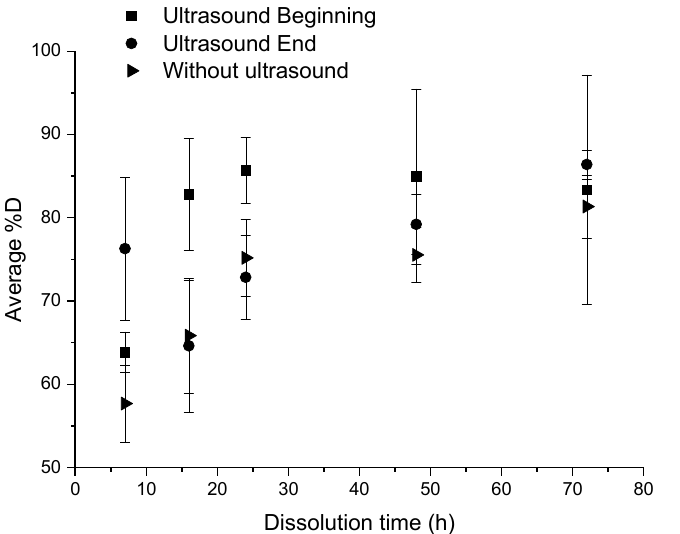
Figure 3. Influence of different ultrasonic conditions on the average % D as a function of dissolution time for a “composite:acetone” ratio of 1:4.